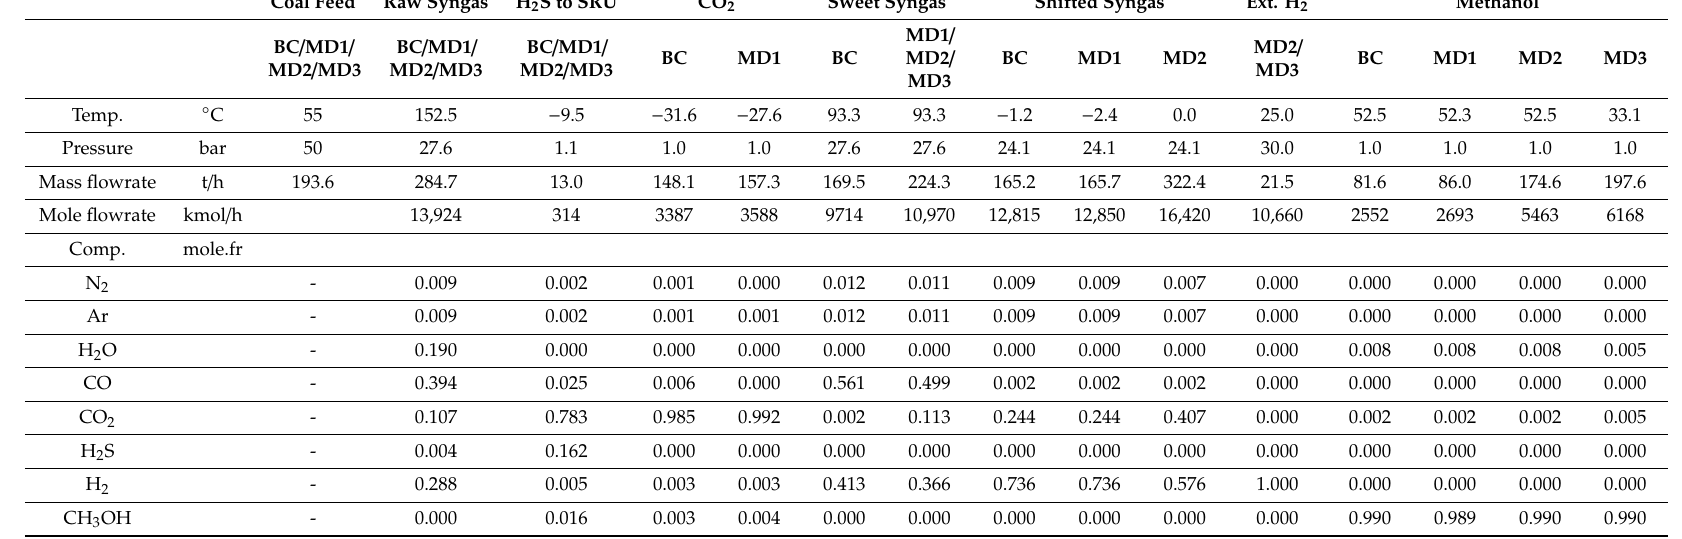
Table 3. Main stream information for the four